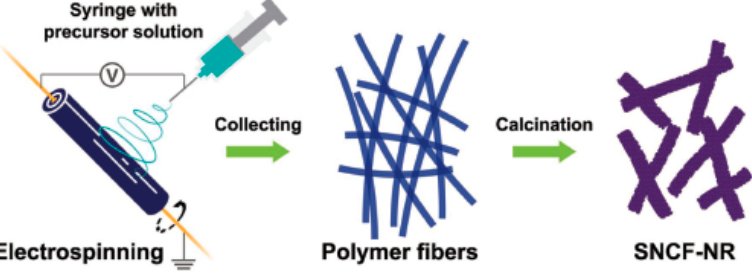
Figure 20. Preparative route to SrNb 0.1 Co 0.7 Fe 0.2 O 3 −δ perovskite nanorods by electrospinning. Reproduced from [64], with permission from John Wiley and Sons, copyright 2017.